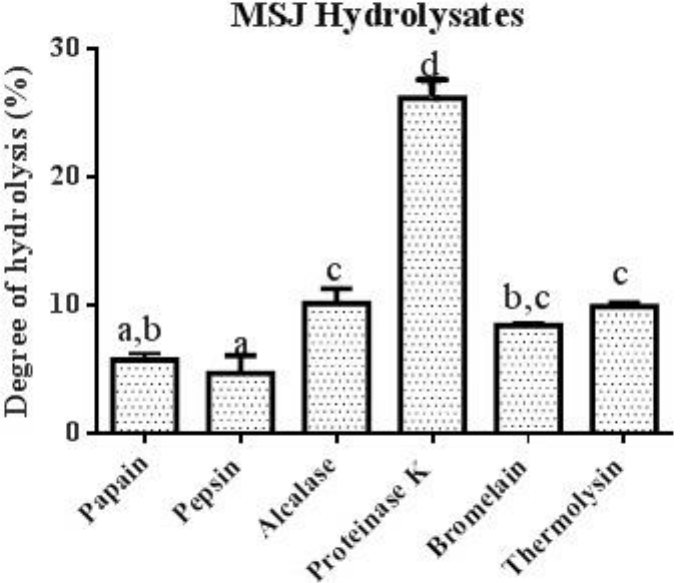
Figure 6. Degree of hydrolysis (%) of MSJ hydrolysates with six proteases at 4 h of hydrolysis. Different alphabets on each bar show significant difference at p < 0.05.